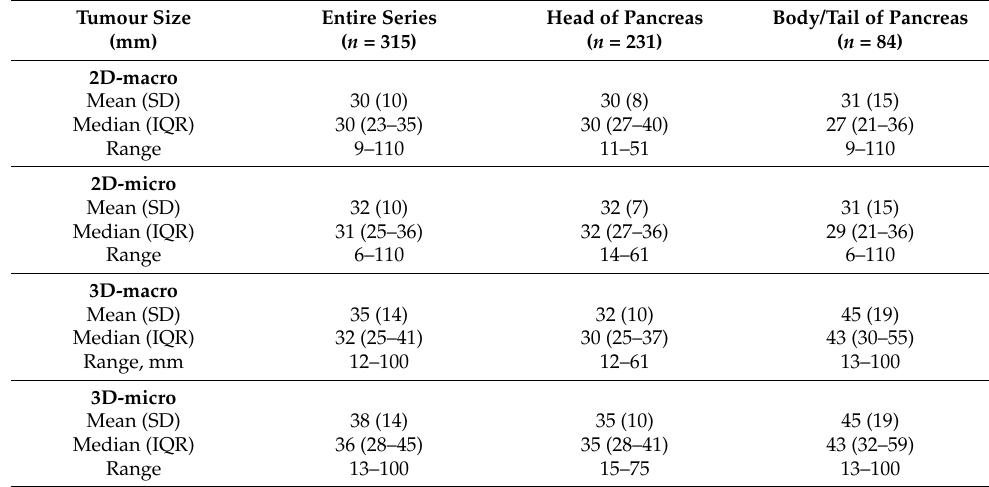
Table 2. Tumour size obtained by various measurement